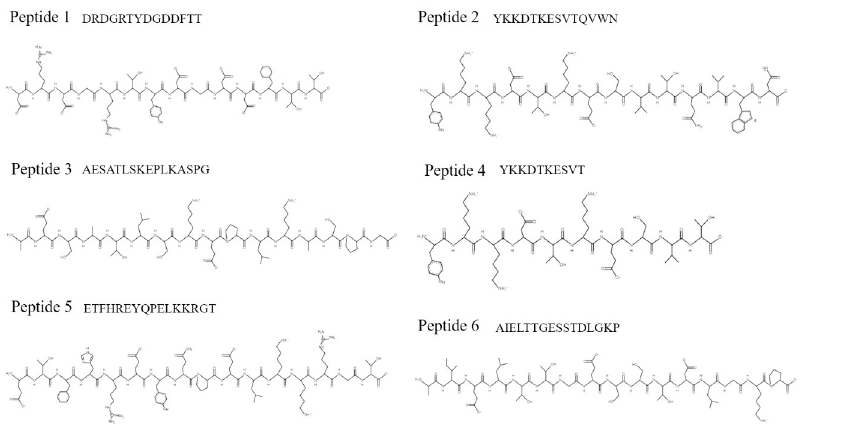
Fig 1. Peptides chemical structure by PepDraw.